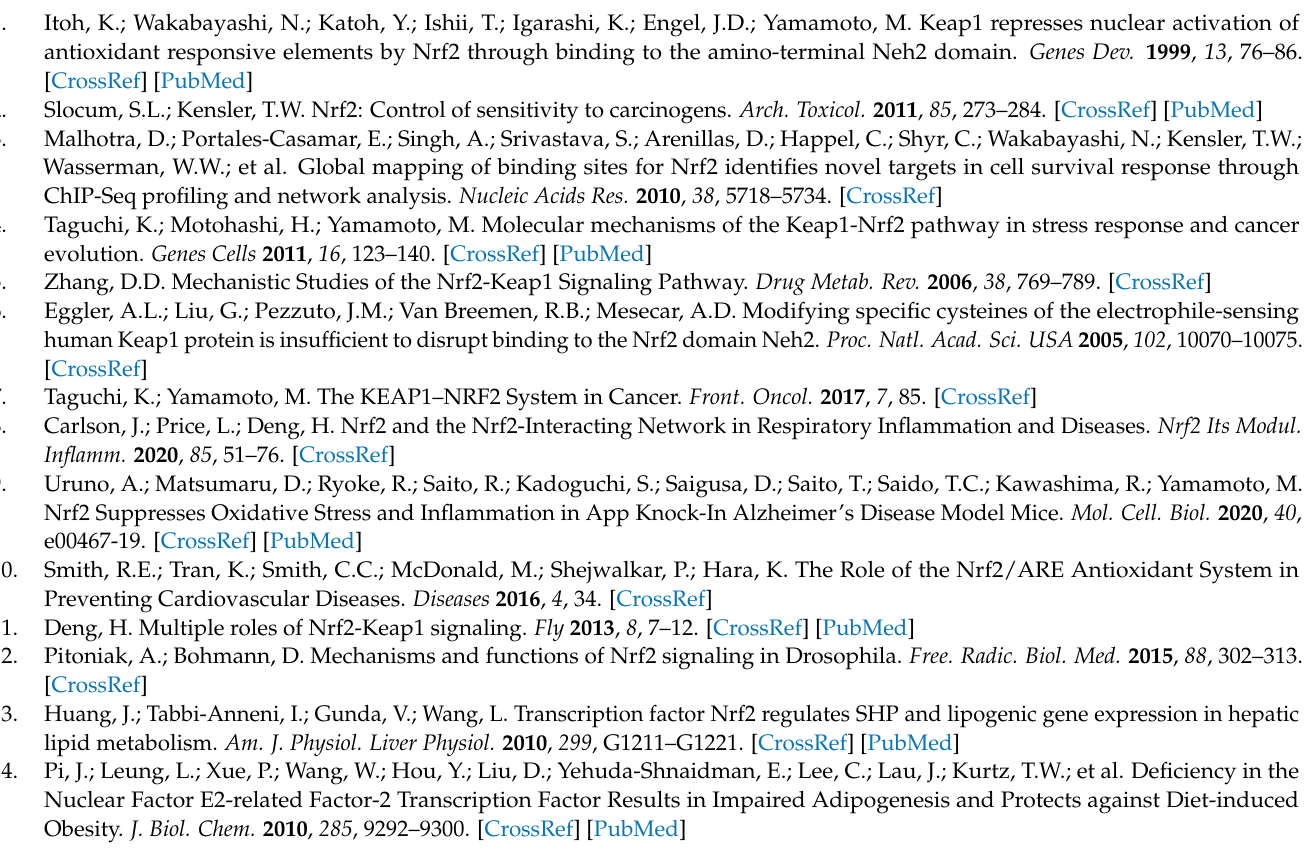
gland cells; Figure S2: Comparison of CncC-Pnr BiFC and individual proteins at chromatin loci; Figure S3: CncC protein levels in the pnr mutant. Table S1. Primer sequences used to measure the transcript levels by